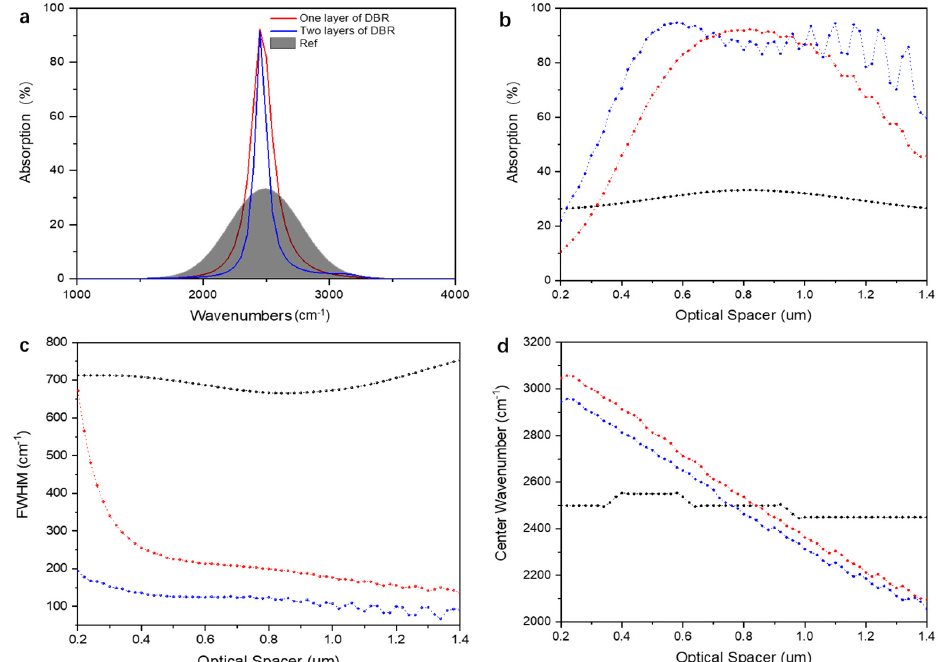
Figure 5. Effect of resonant cavity composed of DBR on CQD detector. ( a ) Absorption of the CQD detector with one layer of DBR, two layers of DBR, and no DBR (Ref) for the thickness of the optical spacer layer is 0.82 µm. Absorption ( b ), FWHW ( c ), and center wavenumber ( d ) of absorption peak of the CQD detector at different thicknesses of the optical spacer layer with one layer (red line), two layers (blue line) of DBR, and no DBR (black line).